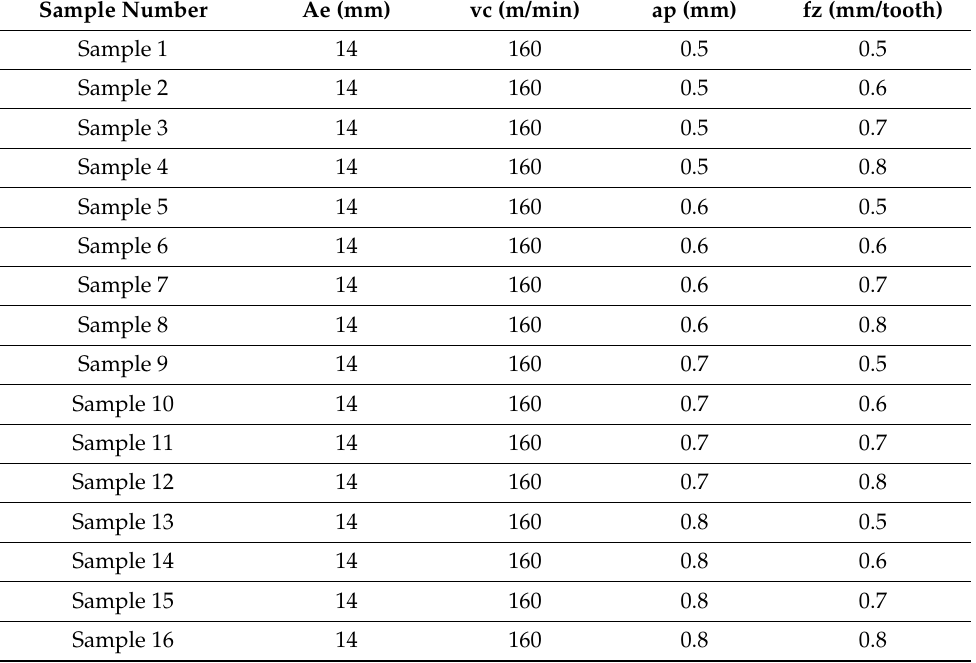
Table 4. Cutting conditions of the experiment.